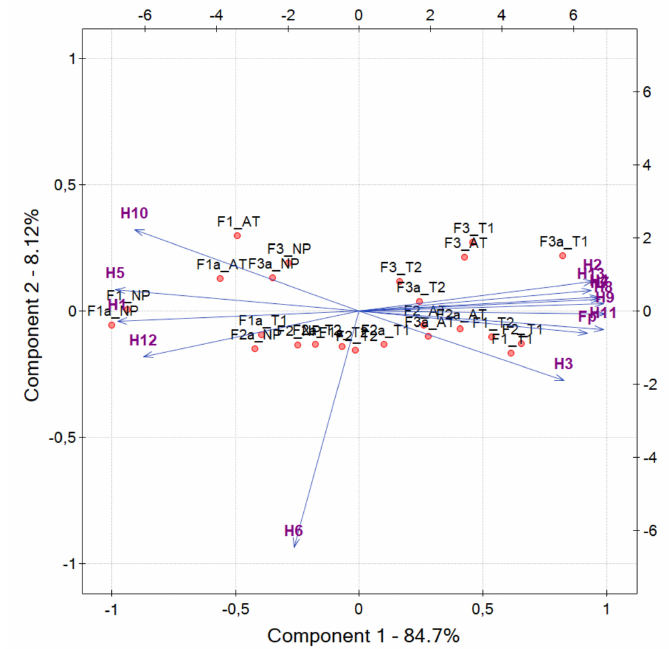
Figure 9. Score plot for PC 1 and PC 2 for different fabric abrasion tests, where: F 1, F 2, F 3—tested fabrics; NP —not pilled (control) sample; T 1, T 2—manual tests; AT —apparatus test. A complete